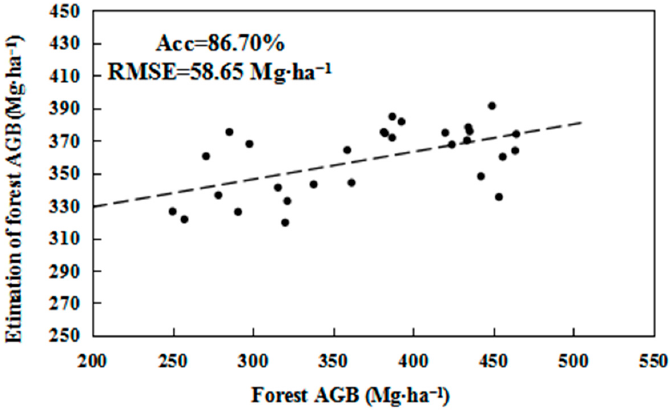
Figure 15. Scatter plot of ground observed with estimated forest AGB by the model taking the BPV-30 as unique feature.